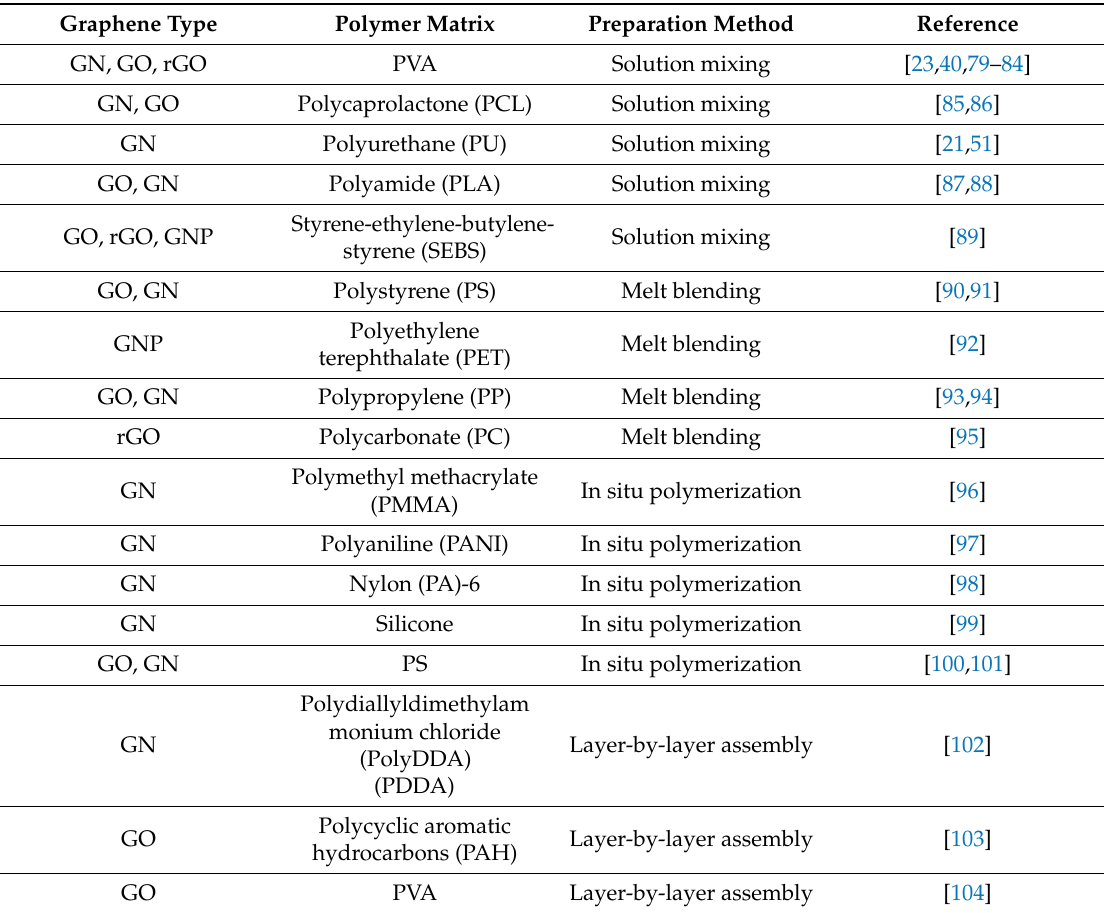
Table 2. Polymer matrix used for graphene reinforced